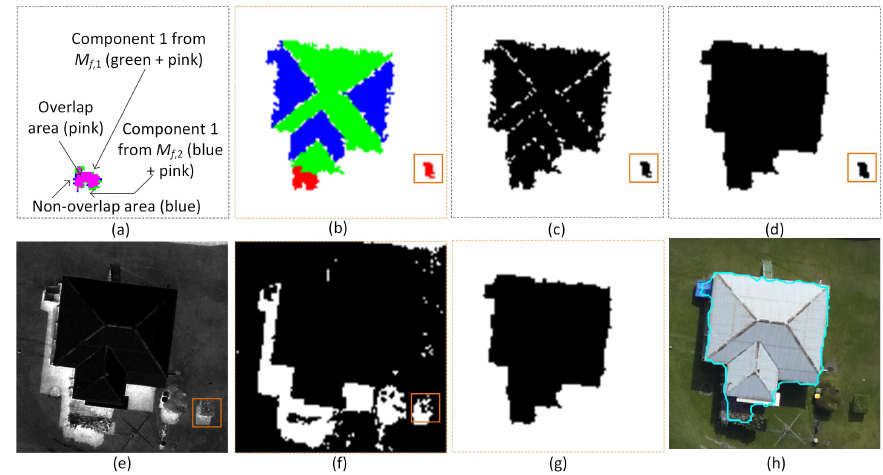
Figure 5. Combining components of sub-masks: (a) analysing overlap and non-overlap areas between components, (b) coloured mask, (c) binary mask, (d) candidate buildings, (e) normalised difference vegetation index (NDVI) for sample scene in Figure 1(a), (f) NDVI mask, (g) final building mask and (h) final building